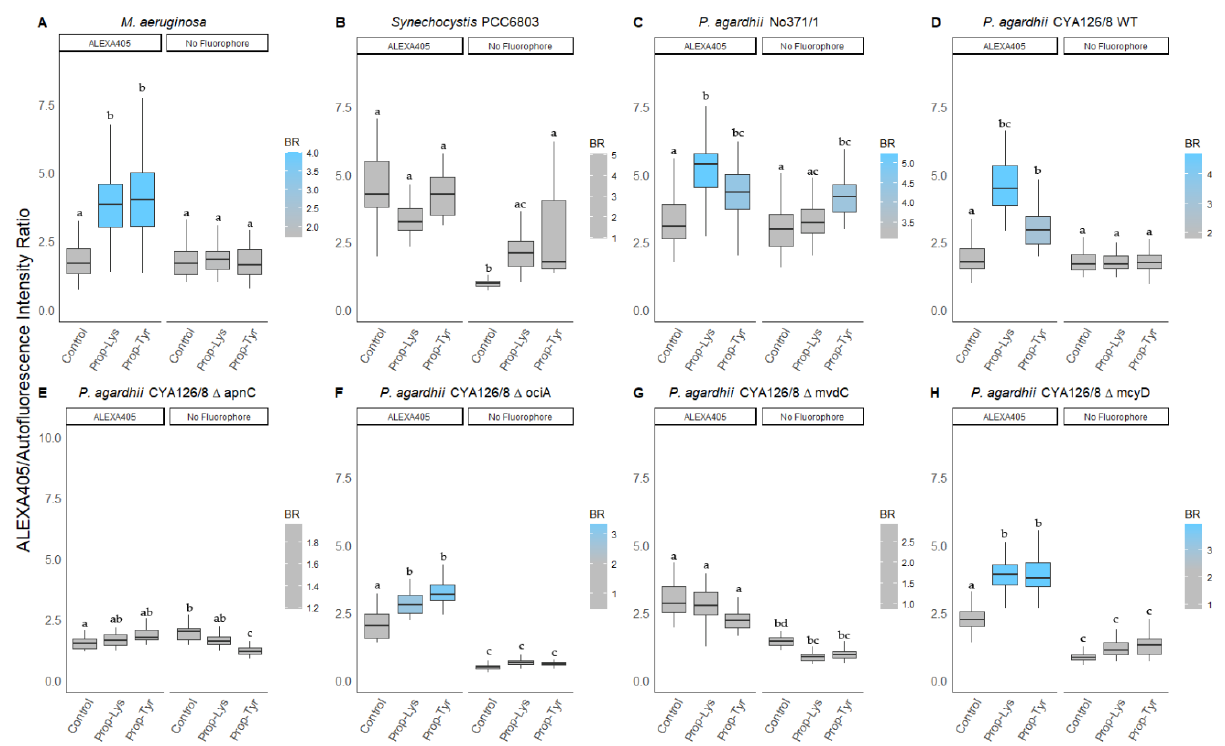
Figure 4. The ratio of blue fluorescence intensity (ALEXA405) to red intensity (AF) for individual cells or filaments from ( A ) M. aeruginosa , ( B ) Synechocystis PCC6803, and ( C ) P. agardhii strain No371/1, ( D ) CYA126/8 WT, and ( E – H ) CYA126/8 gene knock out mutants: ( E ) ∆ apnC (inactivated AP synthesis), ( F ) ∆ ociA (inactivated cyanopeptolin synthesis), ( G ) ∆ mvdC (inactivated microviridin synthesis), and ( H ) ∆ mcyD (inactivated MC synthesis) using non-natural amino acids (Phe-Az, Prop-Lys, and Prop-Tyr). Controls were grown without amino acid addition but used for the chemical reaction under identical conditions. No Fluorophore indicates filaments or cells grown with amino acid addition but no subsequent labeling by click-chemical reaction. The gradient in coloring was defined for each strain separately using the average intensity from the control cultures. Superscripts indicate statistically significant different subgroups after overall difference was found ( p < 0.05).